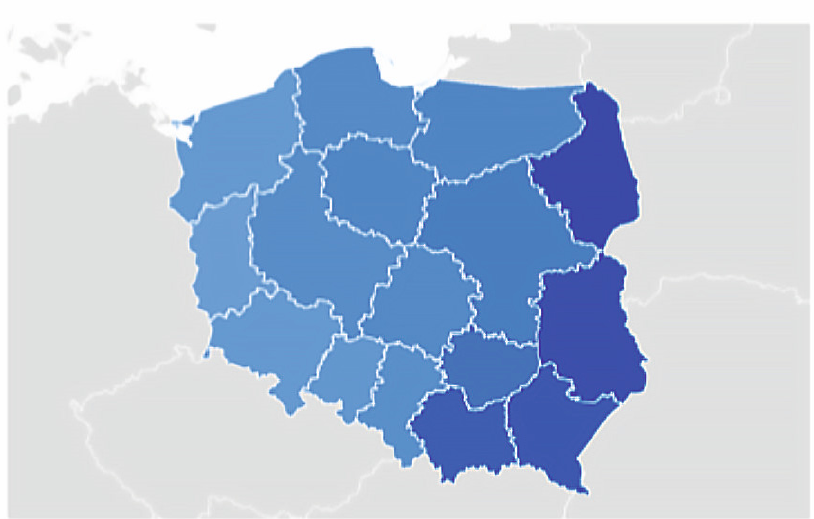
Figure 5. Frequency of searches for the keyword “litany” in the last five years by region; source: Google Trends, https://www.google.com/trends (accessed on 23 August 2021).